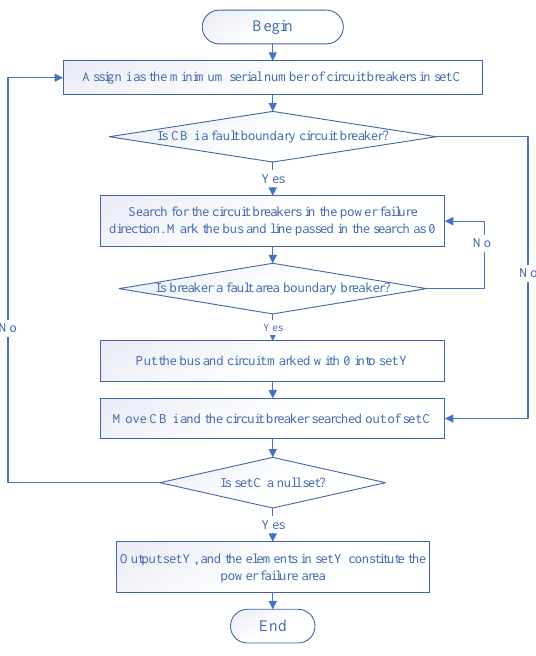
Figure 2. Flow chart of the fault area formation algorithm.